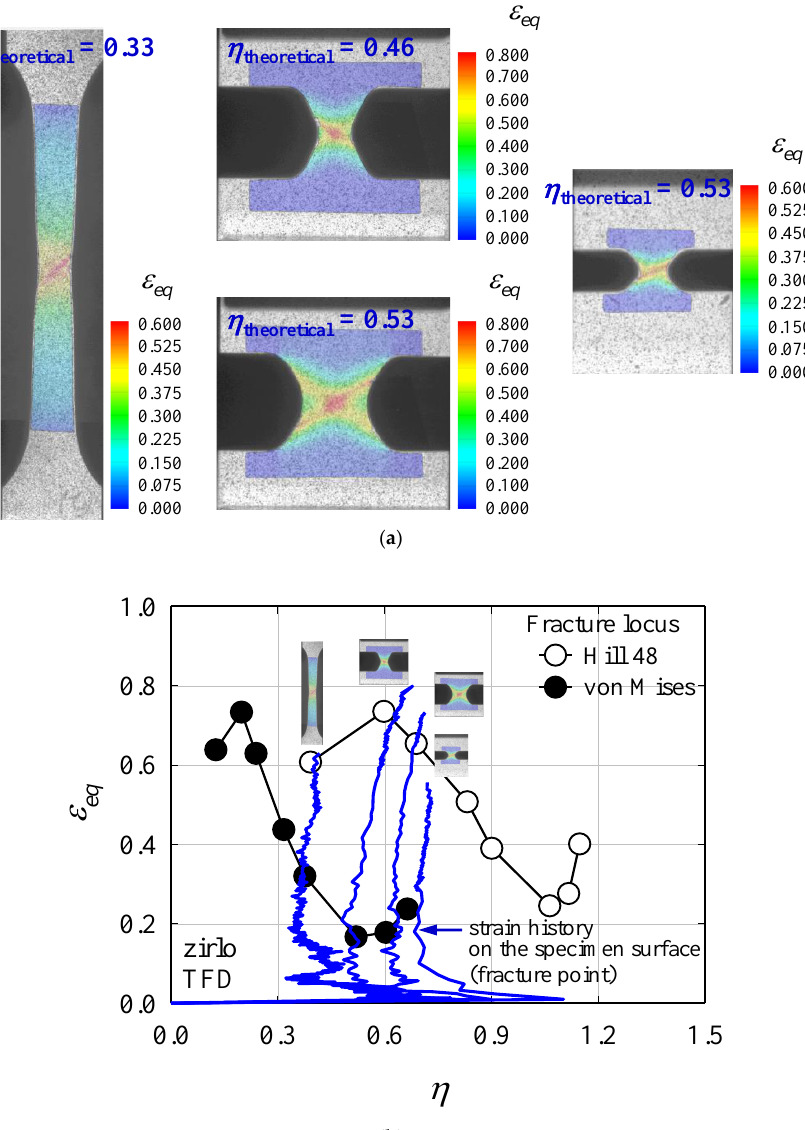
Figure 11. ( a ) Distribution of ε eq at fracture. ( b ) Comparison of forming limit with converted TFD.